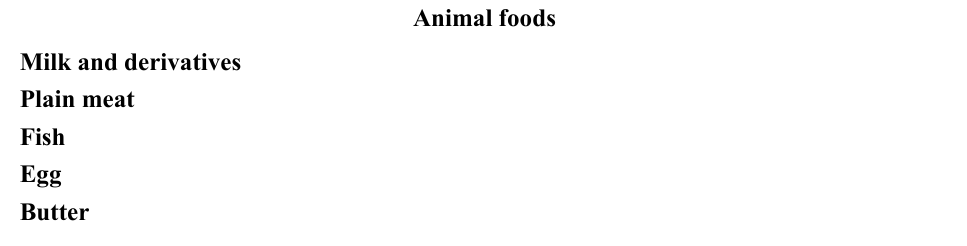
Table 2. Cont. Animal foods